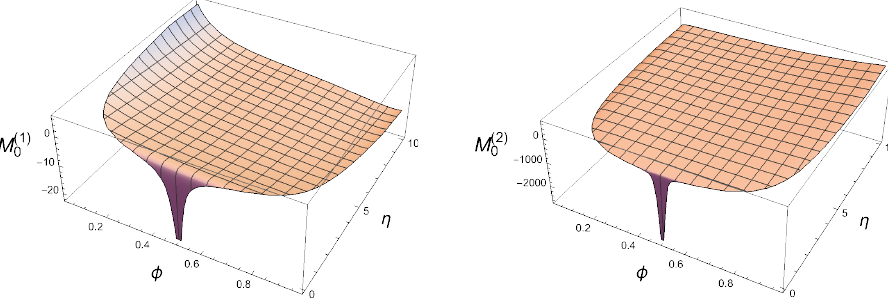
, n = 1 , 2 , of the renormalised one- 0 = 3 , n = 5 , and n = 1 c l h